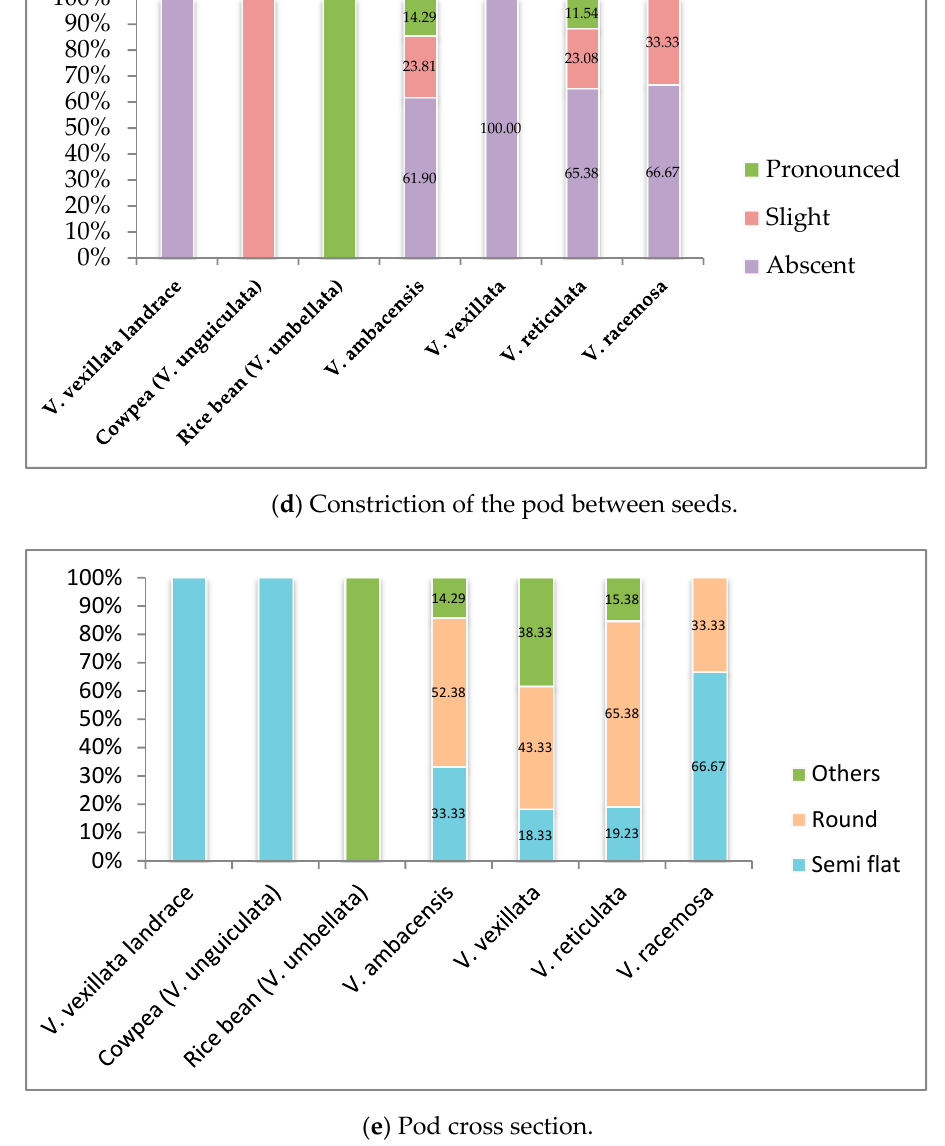
Figure 5. Variations in some selected qualitative traits, evaluated at the maturity and podding stages. ( a ) pod attachment to peduncle; ( b ) pod pubescence; ( c ) pod curvature; ( d ) constriction of the pod between seeds; ( e ) pod cross section.